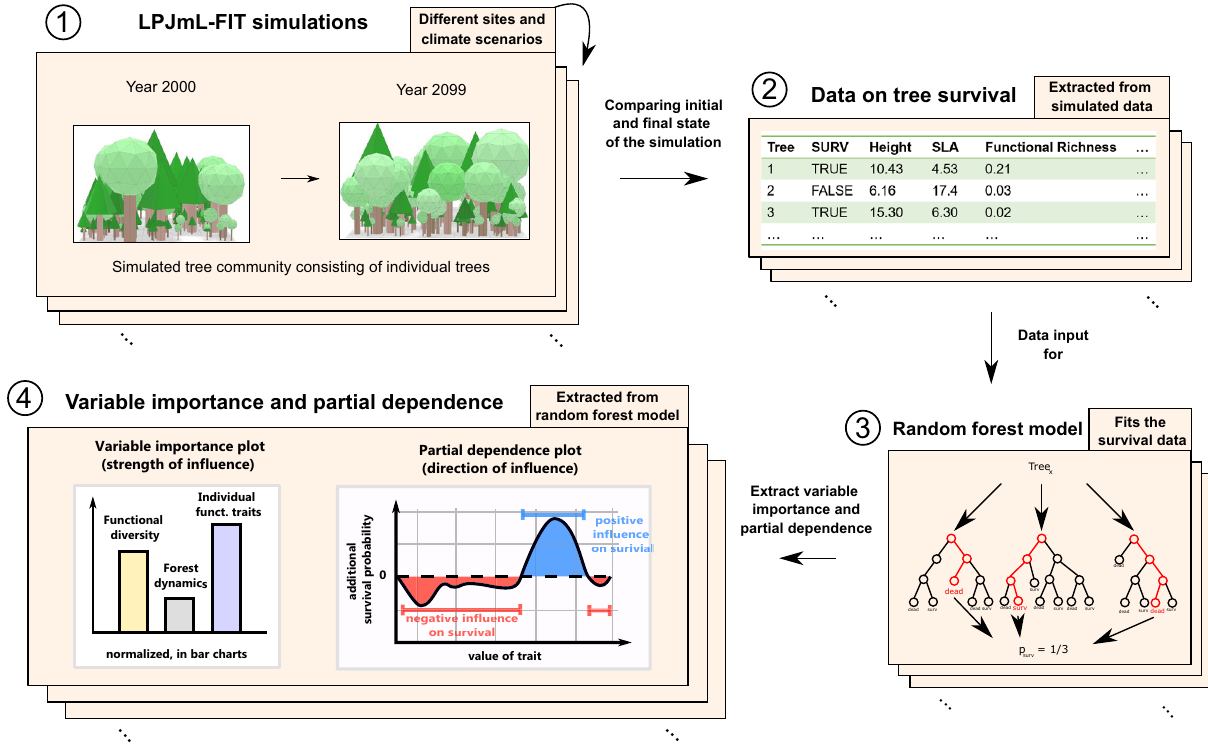
... Figure 1. Summarizing scheme of the study design for different sites and climate scenarios. 1: LPJmL-FIT simulating individual trees applied to four European natural forests from year 2000 to 2099 under reference climate and future climate scenarios (here two exemplary snapshots from model output visualizations of Fig. 3— Supplementary Video 1). 2: Obtain data on tree survival from simulated tree community and on individual functional traits. 3: Initial forest conditions are used to predict tree survival probability through a random forest algorithm. 4: Variable importance and partial dependence plots are extracted from the random forest models for each variable and visualized in bar plots and line charts. A detailed description of the workflow can be found in